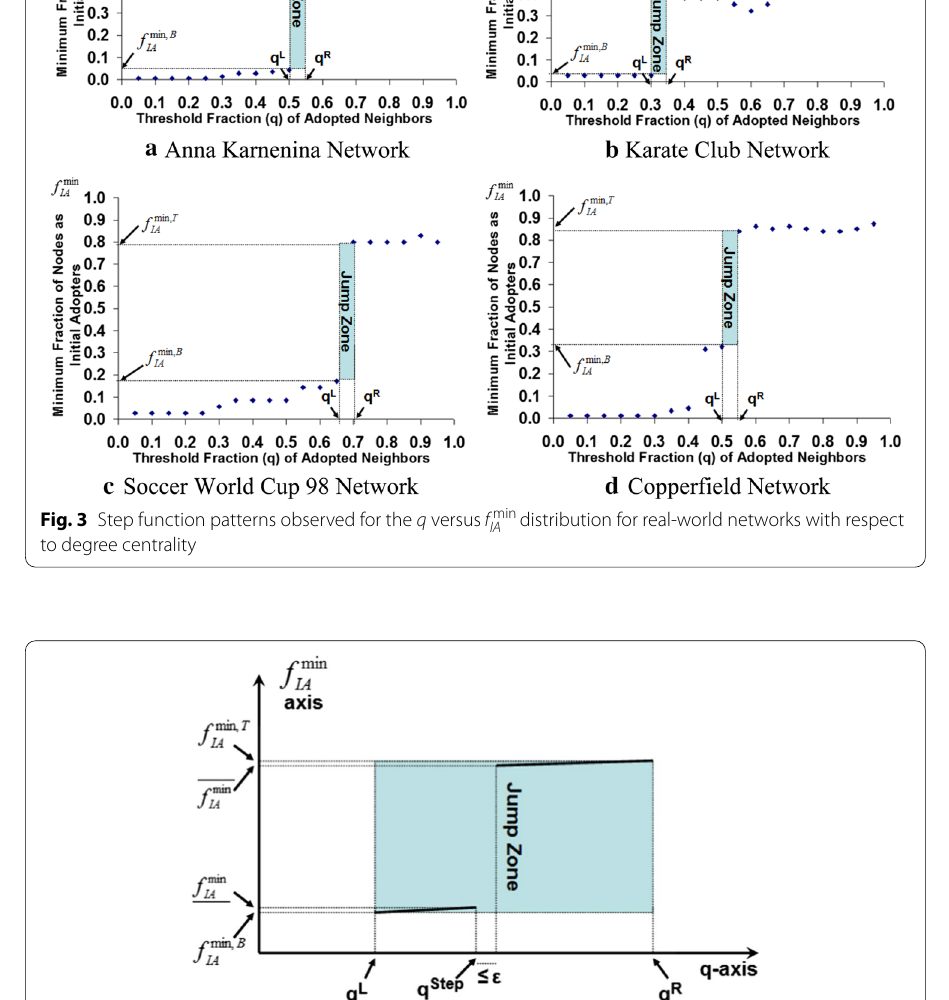
Analysis of the relationship: q versus f min IA